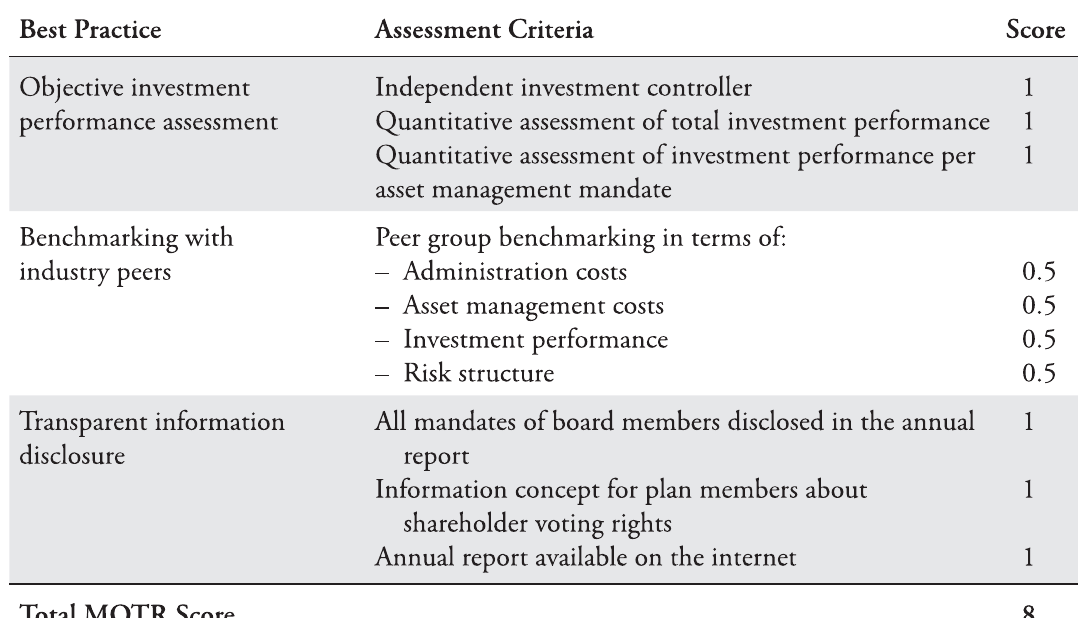
Table 6: Composition of the MOTR